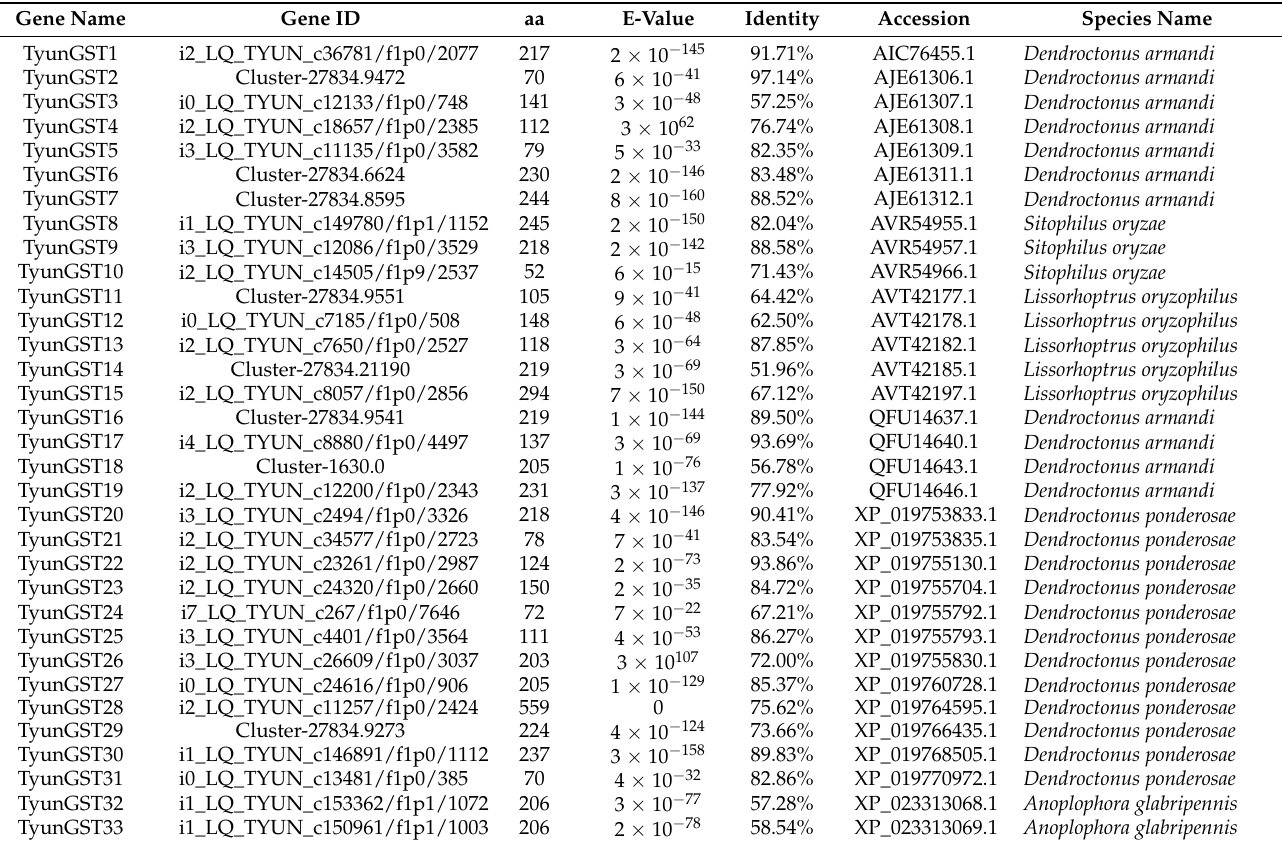
Table 5. Best BLASTX matches of T. yunnanensis